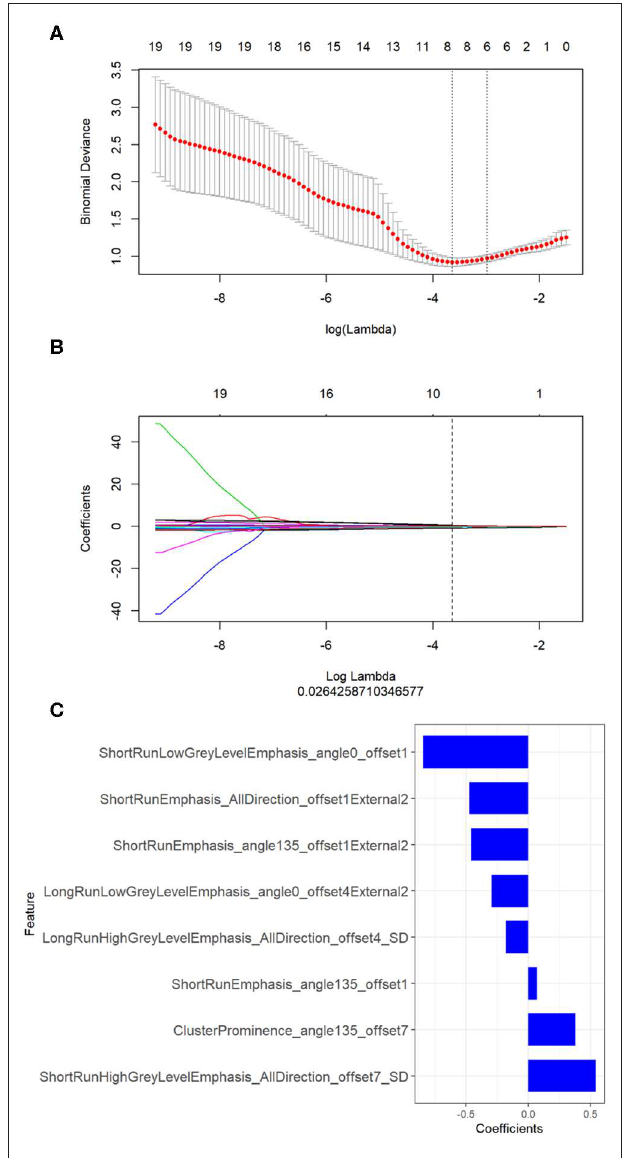
FIGURE 3 | Texture feature selection by using the least absolute shrinkage and selection operator (LASSO) about the gross radiomics. (A) Optimal feature selection according to AUC value; (B) LASSO coefficient profiles of the 20 radiomic features. A vertical line was drawn at the selected value using 10-fold cross-validation, where the optimal λ resulted in eight non-zero coefficients; (C) The selected radiomic features and their coefficients about the gross radiomic